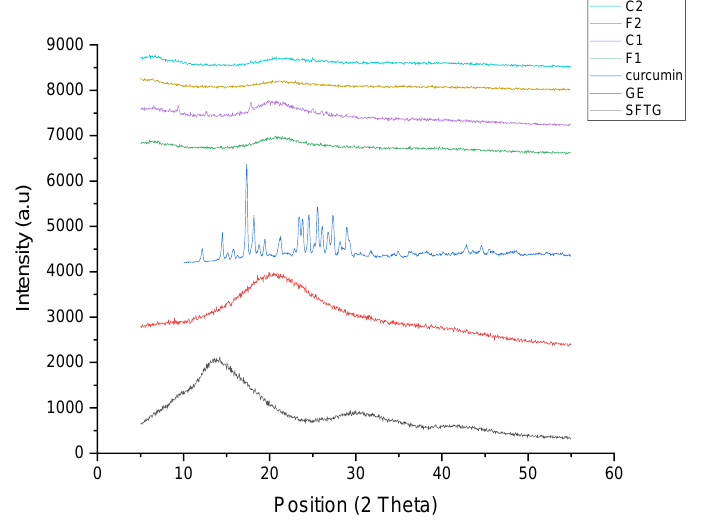
Figure 3. XRD patterns of curcumin, SFTG, GE, and film samples. F1 (1GE: 1SFTG); F2 (2GE: 1SFTG); C1 (1GE: 1 SFTG/curcumin); C2 (2GE: 1SFTG/curcumin).